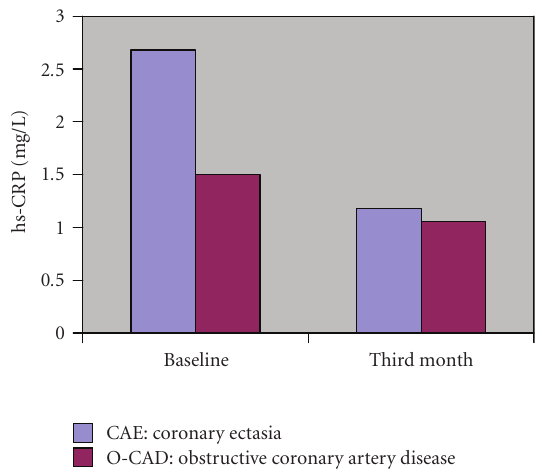
Figure 1: The hs-CRP levels in both groups at baseline and third month. Table 3: hs-CRP Levels (mg/L) and number of vessel involve- ments. CAE denotes coronary ectasia and O-CAD denotes obstruc- tive coronary artery disease. Number of vessel CAE involvements